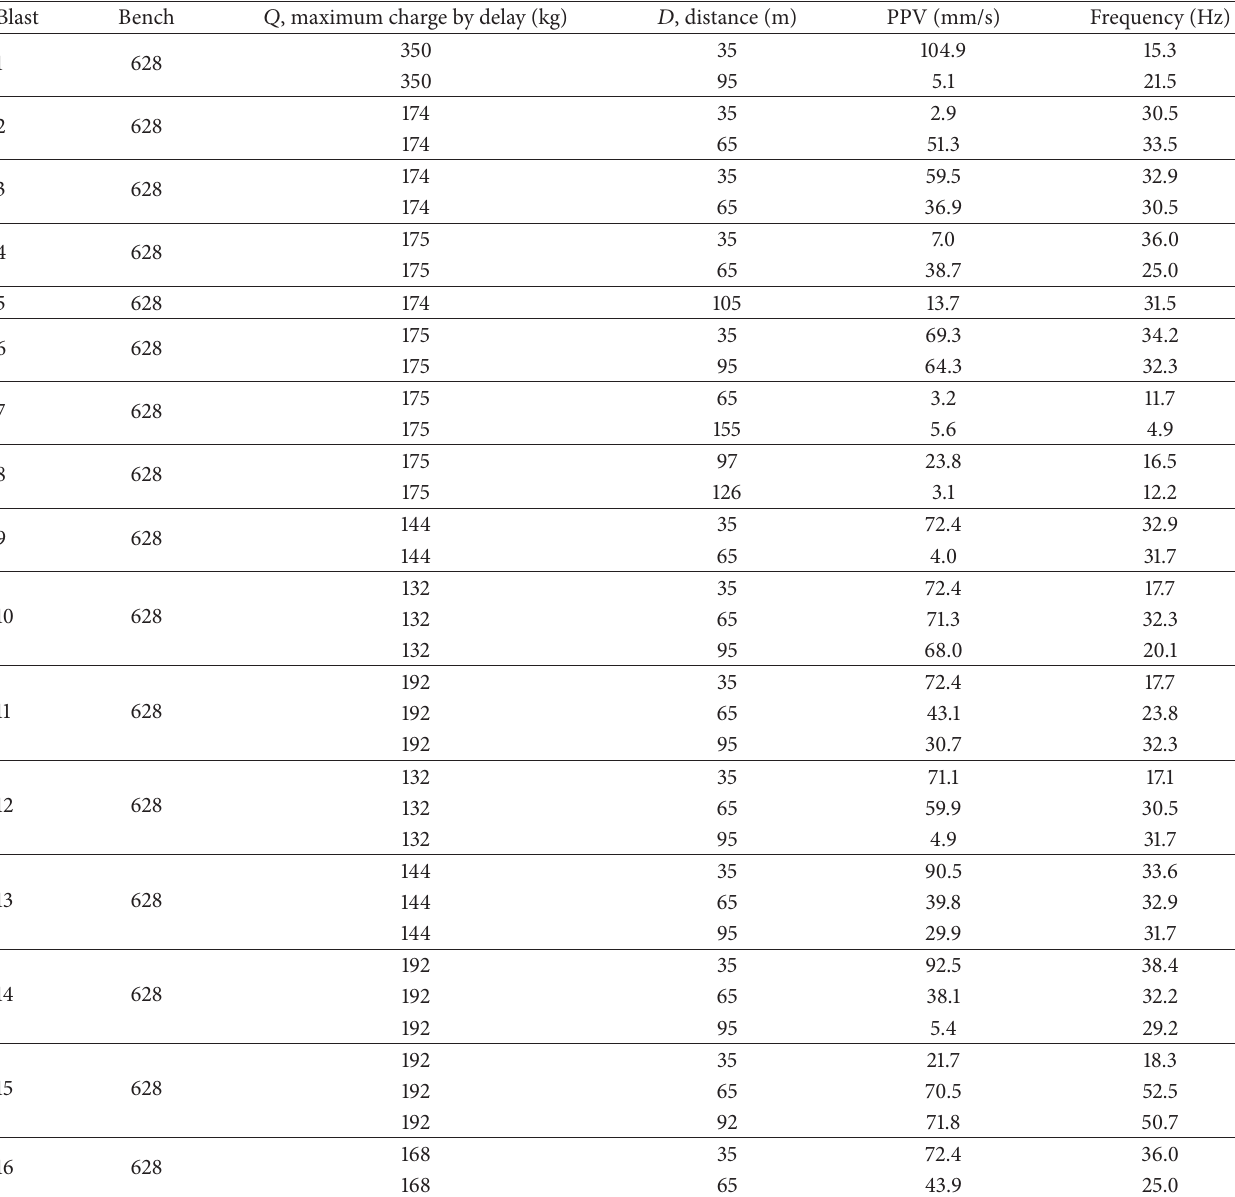
Table 3: Vibration measurements taken on surface.